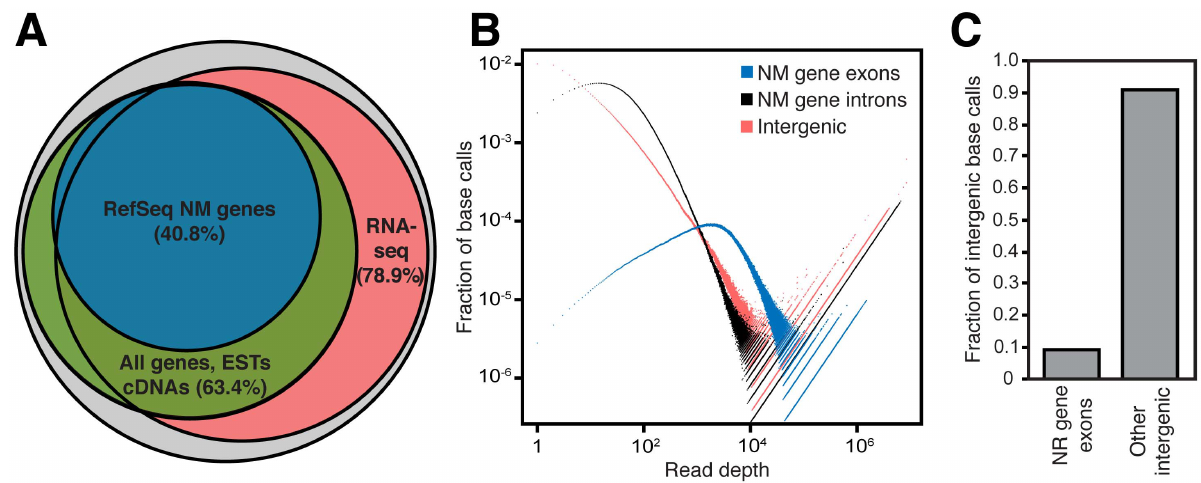
Figure 1. The human intergenic transcriptome. (A) 85.2% of the genome has evidence of transcription, with RNA-seq reads mapping directly to 78.9% of genomic sequence. The remaining genomic coverage is comprised of known genes, spliced ESTs and spliced cDNAs. The grey circle represents the portion of the genome (83.4%) that is uniquely mappable with RNA-seq reads. (B) Protein coding (NM gene) exon, intron and intergenic region expression level distribution. Regions that have high expression have a larger fraction of base calls appearing at higher read depths. Protein coding gene exons have the highest proportion of bases with high read depth, while introns and intergenic regions have relatively more bases of low read depth though each contain many highly expressed regions. Base calls=( # of genomic positions at a specific read depth)(read depth). (C) Most intergenic transcription is outside of annotated noncoding RNA genes. The fraction of intergenic base calls within RefSeq noncoding RNA genes (NR genes) compared to other intergenic regions are compared. In (A–C), only uniquely mappable portions of the genome are considered (see Methods).